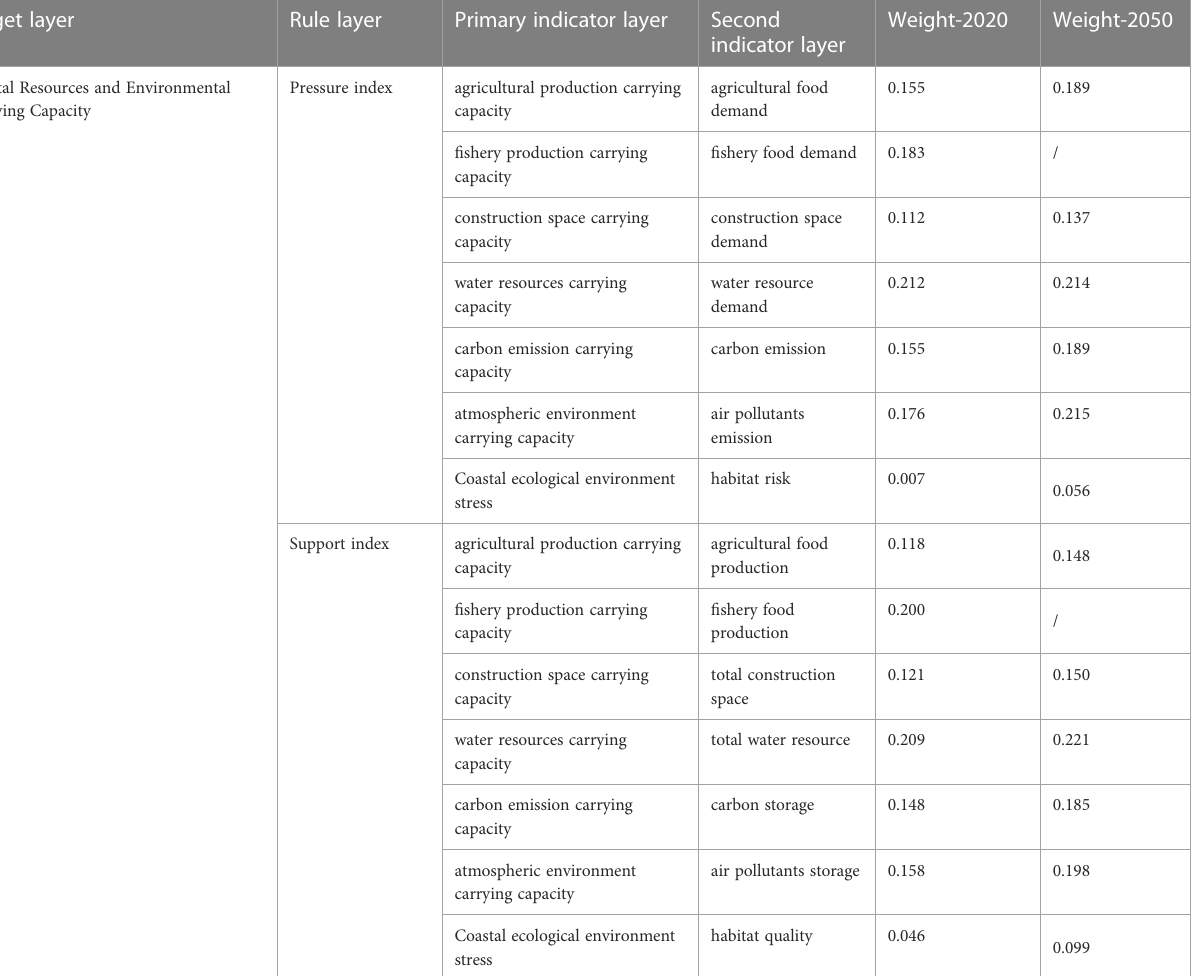
TABLE 1 Index system and weight for Coastal Resources and Environmental Carrying